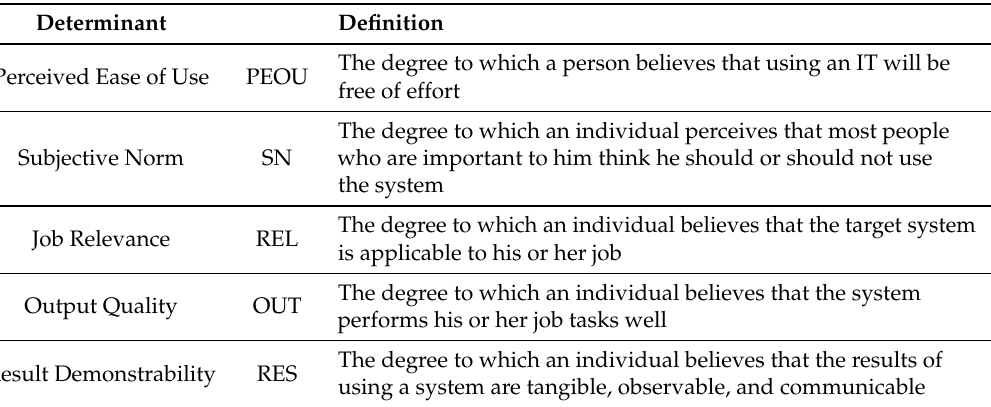
Table 2. Determinants for perceived